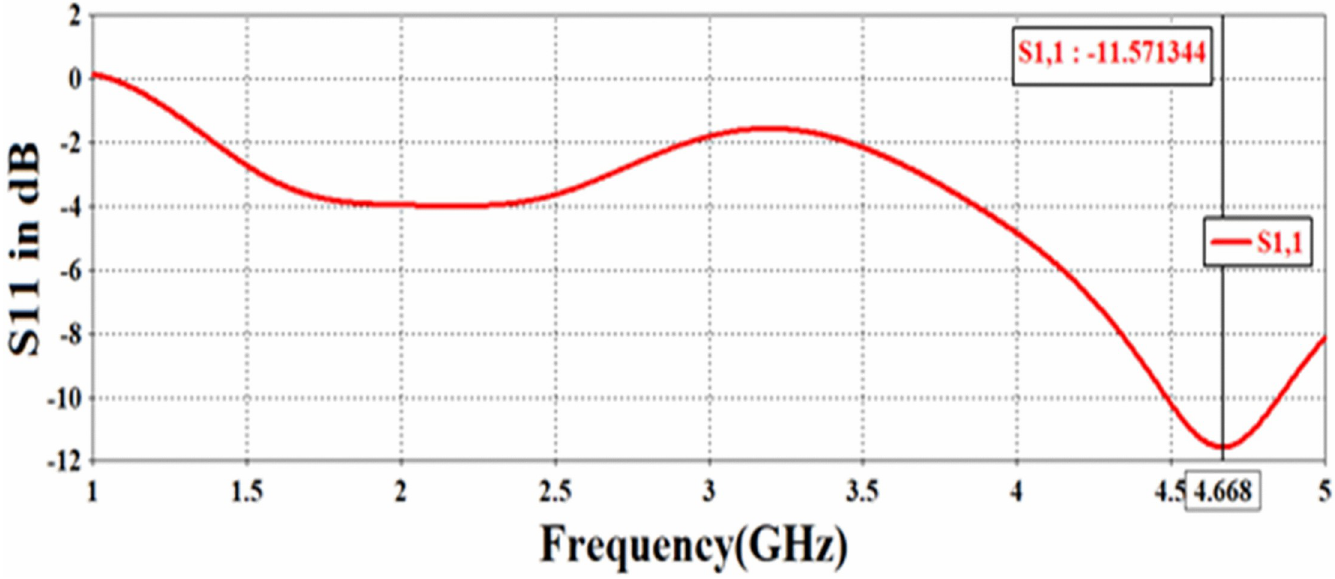
Fig 6. Return loss (S 11 ) spectra of the proposed PCB rectangle patch antenna.